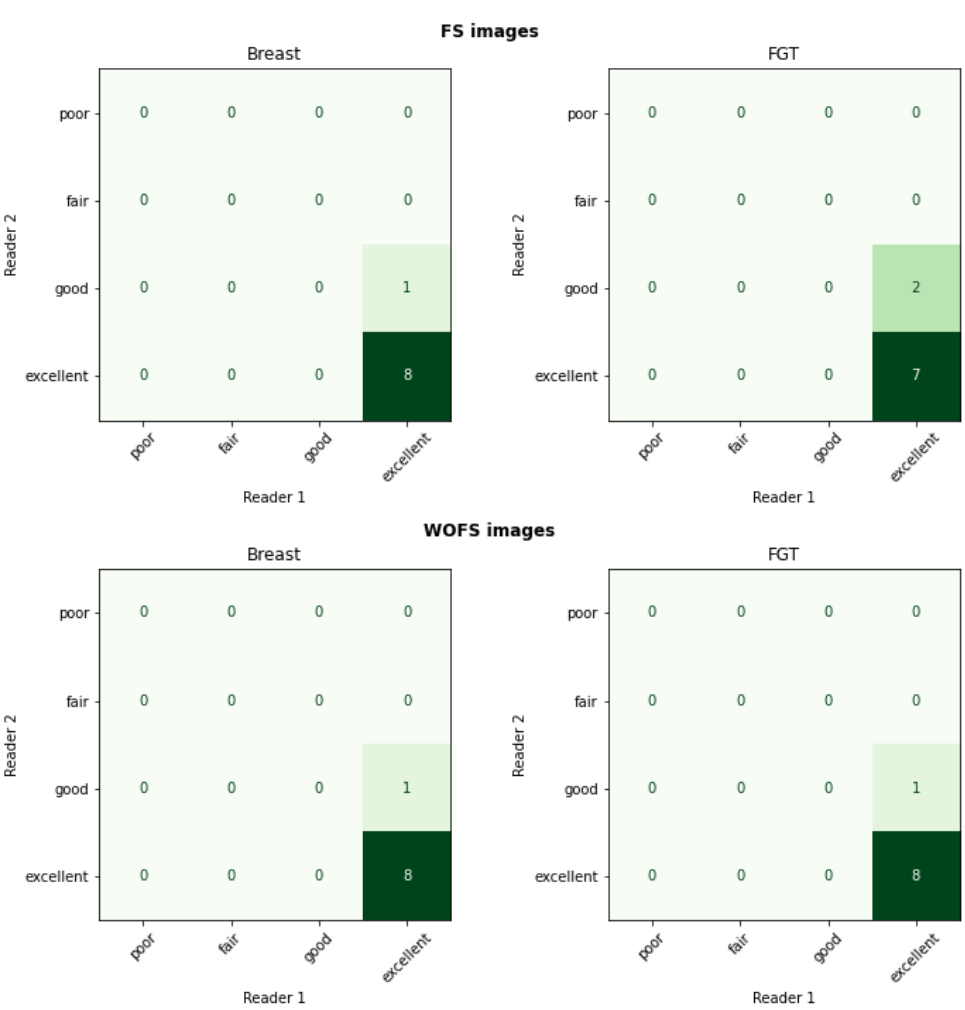
Figure 5. Internal test set results (n = 9 patients, 18 acquisitions (9 WOFS, 9 FS)). Reader study confu- sion matrix comparing the ratings (1—Poor, 2—Fair, 3—Good, 4—Excellent) from the two